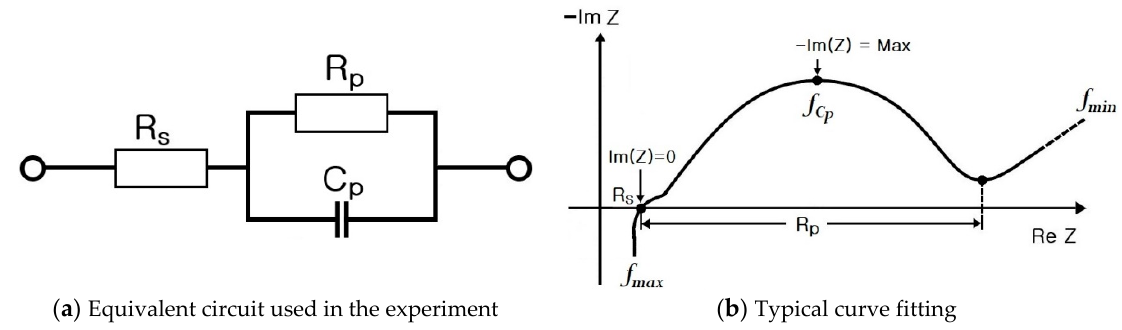
Figure 17. Equivalent circuit and typical curve fitting.